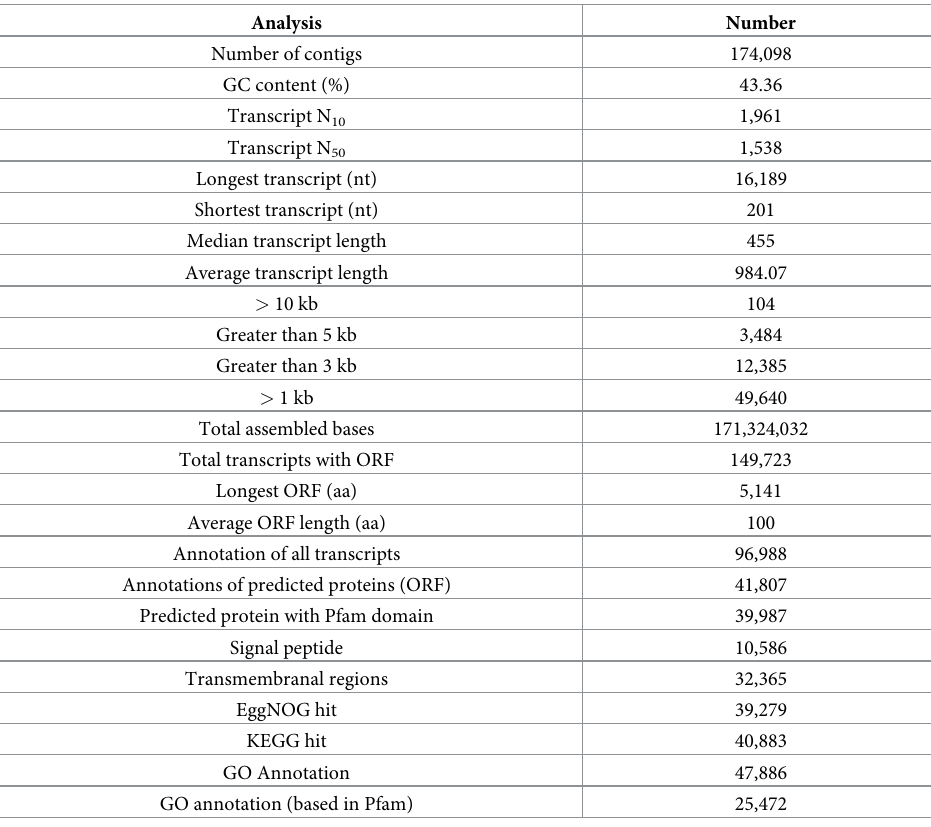
Table 2. Summary of assembly and annotation. Data from the hepatopancreas of Litopenaeus vannamei with